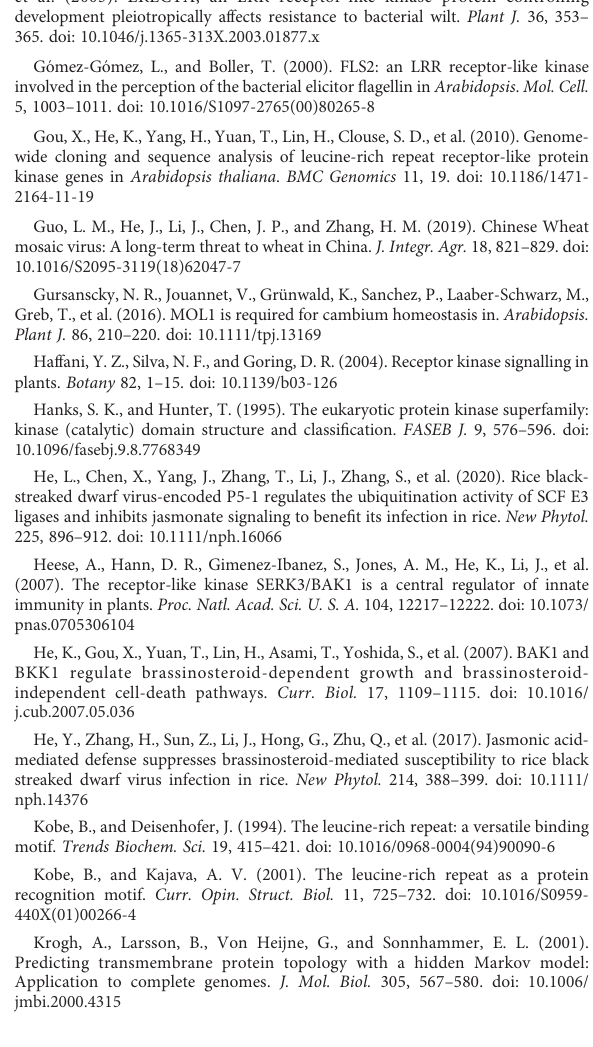
SUPPLEMENTARY FIGURE 1 Detection of CWMV and BSMV by RT-PCR in viuses infected leaves. The infectious clones and wheat leaves without viral infection was used as positive control (+) and negative control (-),